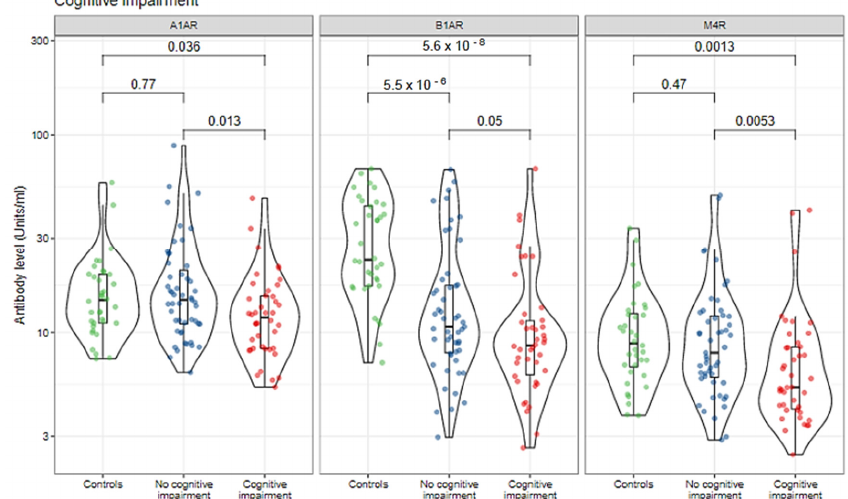
Figure 3. Autoantibodies against autonomic nervous system receptors are correlated with cognitive impairment in symptomatic women with SBIs. Individual measurements are shown as dots, summary data as box plots, and the distributions as violin plots. Green dots: healthy controls; blue dots: silicone-breast-implant patients without clinical manifestations; red dots: silicone-breast-implant patients with clinical manifestations.